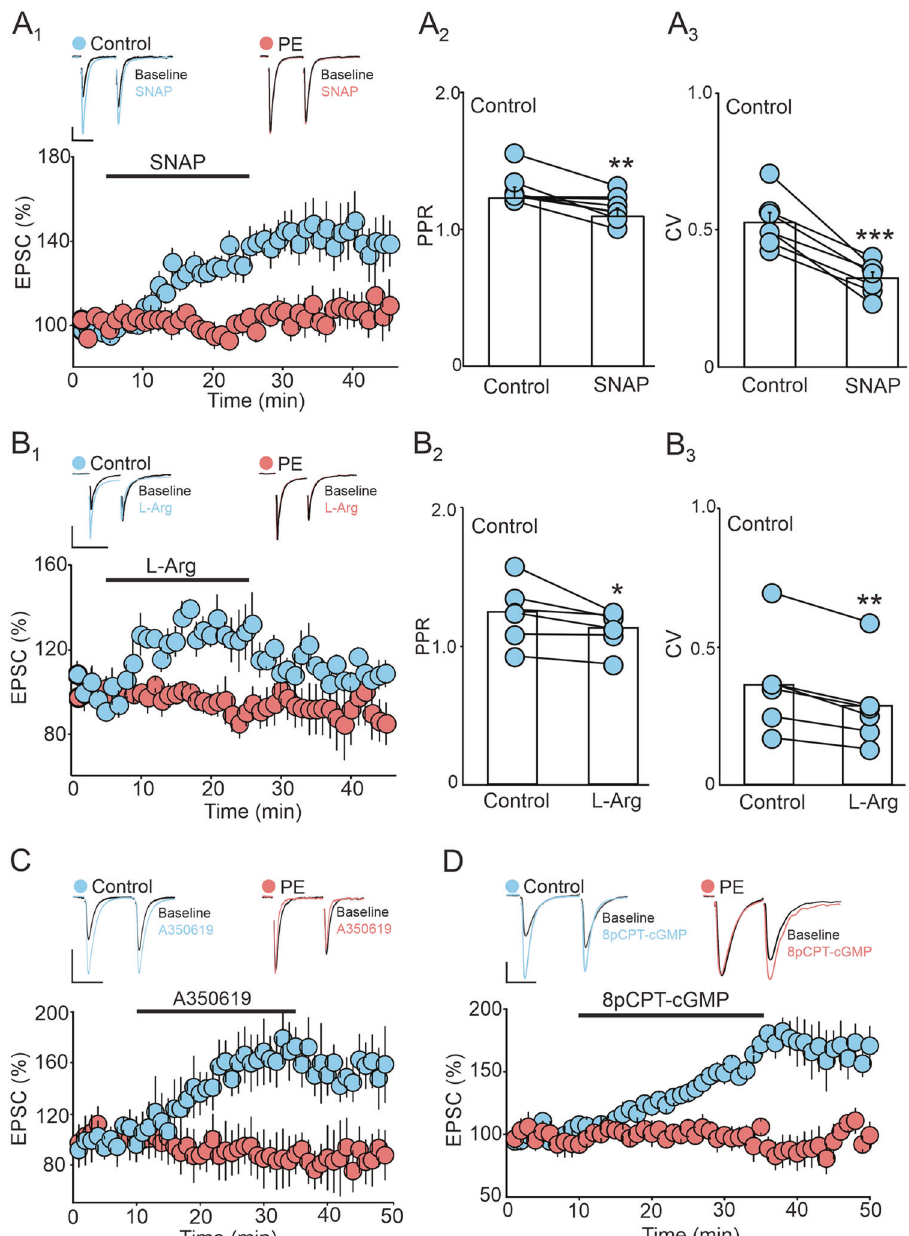
Fig. 5B 2 ) and CV of eEPSCs (Baseline: 0.36 ± 0.07; L-Arg: 0.28 ± 0.06; Fig. 5B 3 ). Finally, because activation of sGC/PKG pathway mediate NO-induced potentiation of DRn glutamate synapses, we assessed the impact of PE on the sGC/PKG pathway-mediated potentiation of eEPSC amplitude. We found that only in control rats, activation of sGC with A350619 (100 µM) enhanced the eEPSC amplitude (Control: 162.68 ± 11.86 % of baseline; PE: 90.40 ± 5.41 % of baseline; p < 0.05, ɳ 2 P = 0.68, PE vs PC; Fig. 5C). Similarly, activation of PKG with 8pCPT-cGMP (100 µM), potentiated the amplitude of eEPSCs only in control rats (Control: 156.23 ± 2.87 % of baseline; PE: 98.13 ± 5.86 % of baseline; p < 0.05, ɳ 2 P = 0.88, PE vs PC; Fig. 5D). Together these results support the hypothesis that a persistent activation of NO/sGC/PKG signaling pathway contribute to the PE-induced potentiation of DRn glutamate synapses. Translational Psychiatry (2022)